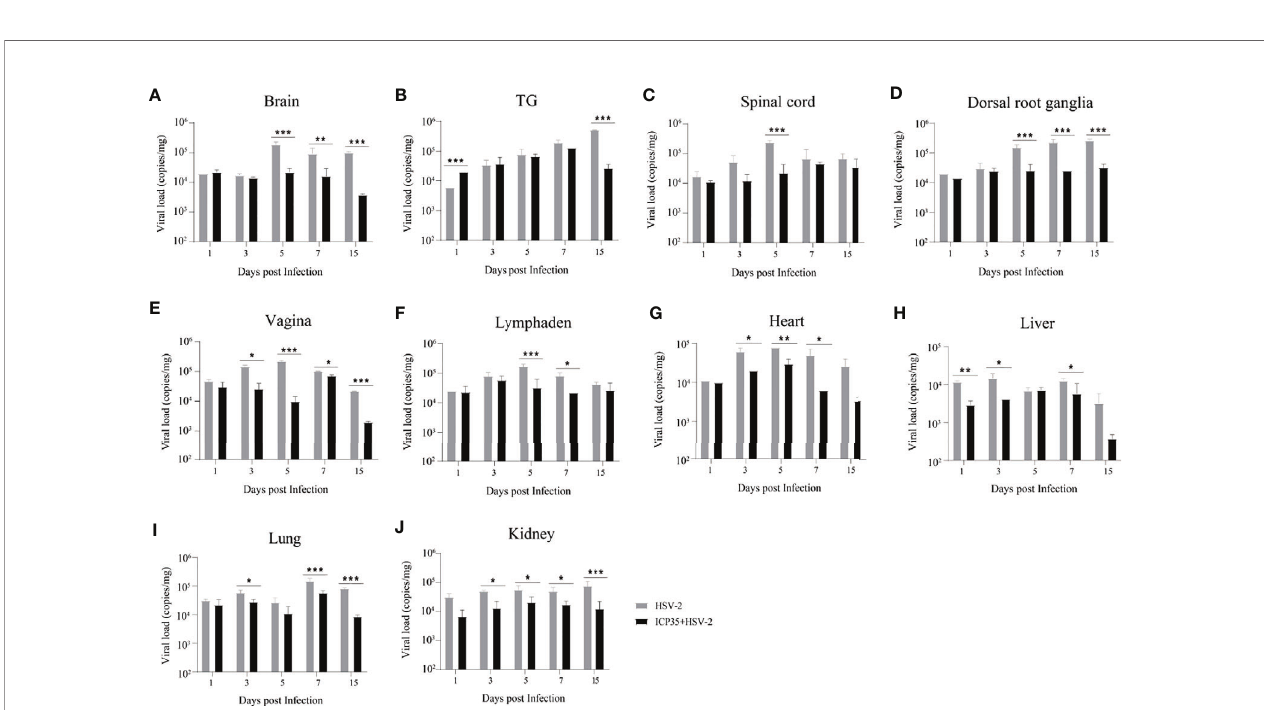
FIGURE 5 | Viral proliferation in various tissues of the ICP35 protein-immunized or control mice. (A – J) The viral loads in various tissues of the immunized mice with ICP35 (ICP35+HSV-2), especially those in the vaginal tissues, were lower than those in various tissues of the mice with Al(OH) 3 adjuvant (HSV-2). (A) Brain, (B) TG, (C) Spinal cord, (D) Dorsal root ganglion, (E) Vagina, (F) Lymphaden, (G) Heart, (H) Liver, (I) Lung, (J) Kidney. The data shown in (A – J) are the mean ± SD of three independent animals. *P<0.05, **P<0.01,